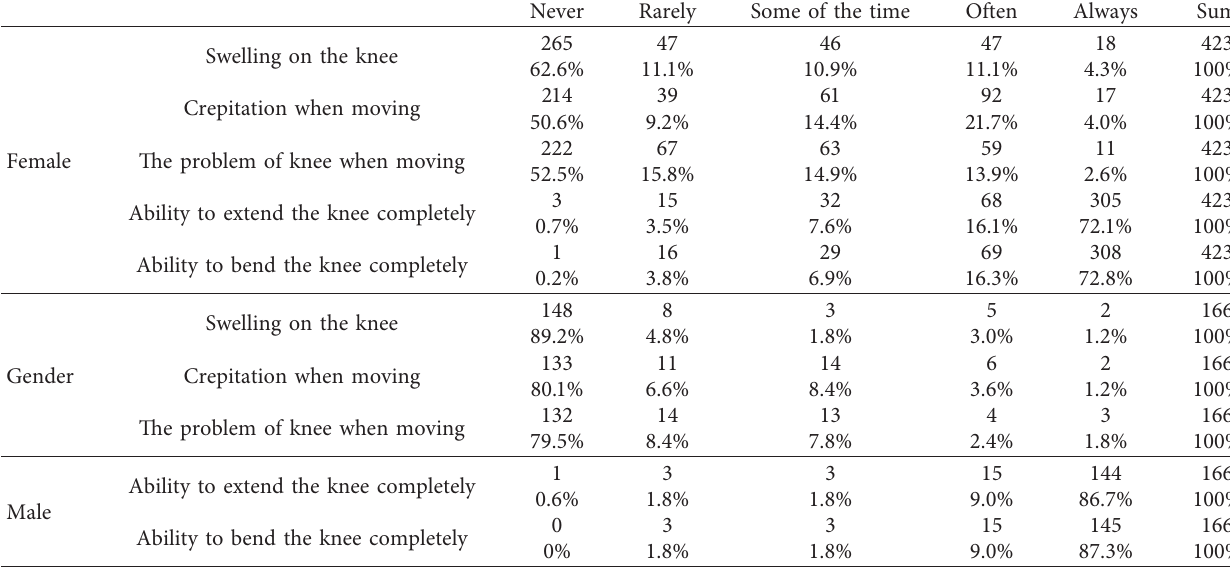
Table 5: The prevalence of knee exhaustion side effects based on the gender.